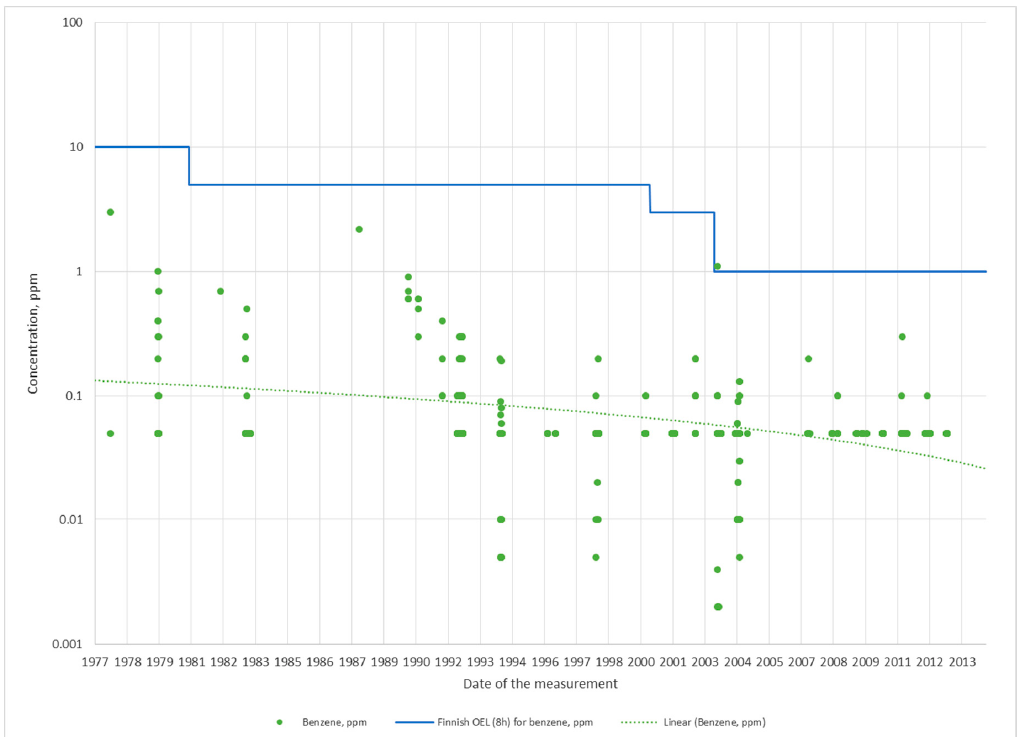
Figure 1. Benzene measurements from production lines 1–4 in Porvoo included in annual monitoring campaigns (average exposure during normal working shifts). Int. J. Environ. Res. Public Health 2018 , 15 , x FOR PEER REVIEW